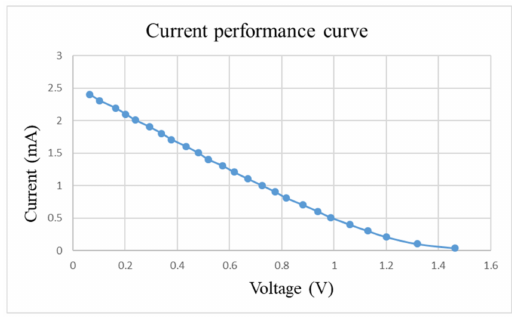
Figure 11. Voltage-performance curve of VRFB.